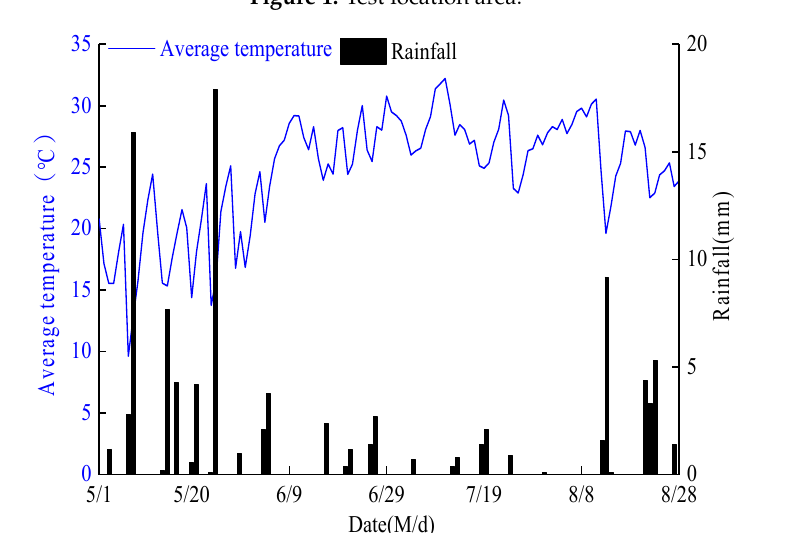
Figure 1. Test location area.